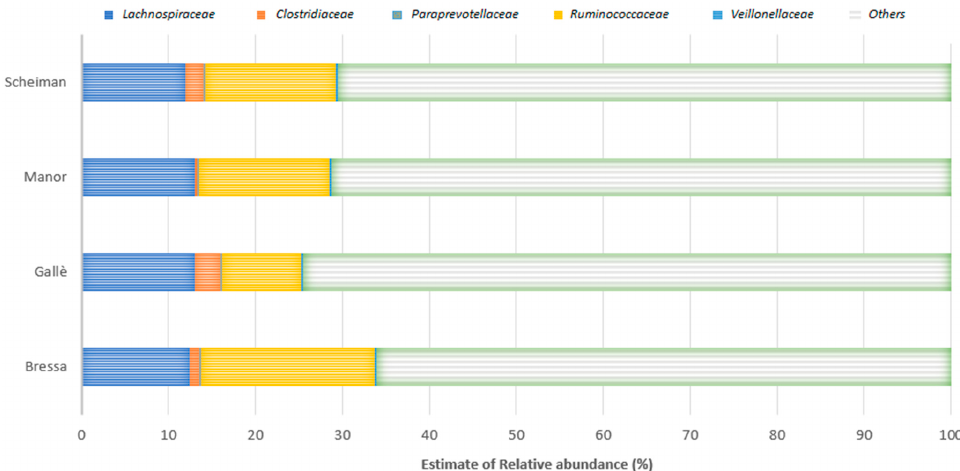
Figure 2. Main results reported by the four investigations that controlled PA effects for diet (Bressa et al., Gall è et al., Manor et al., Scheiman et al.) [32,35,38,39]. Results were expressed as values of bacterial family relative abundance/total number of sequences in the group * 100, rounded to the nearest